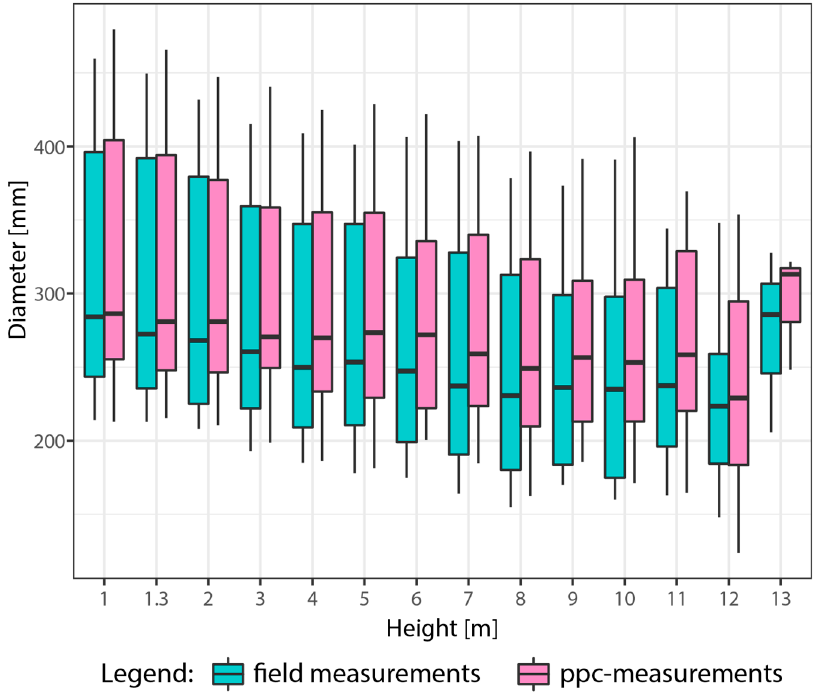
Figure 5. Variation with height of diameters measured in the field and from the PPC for the side-view measurements.